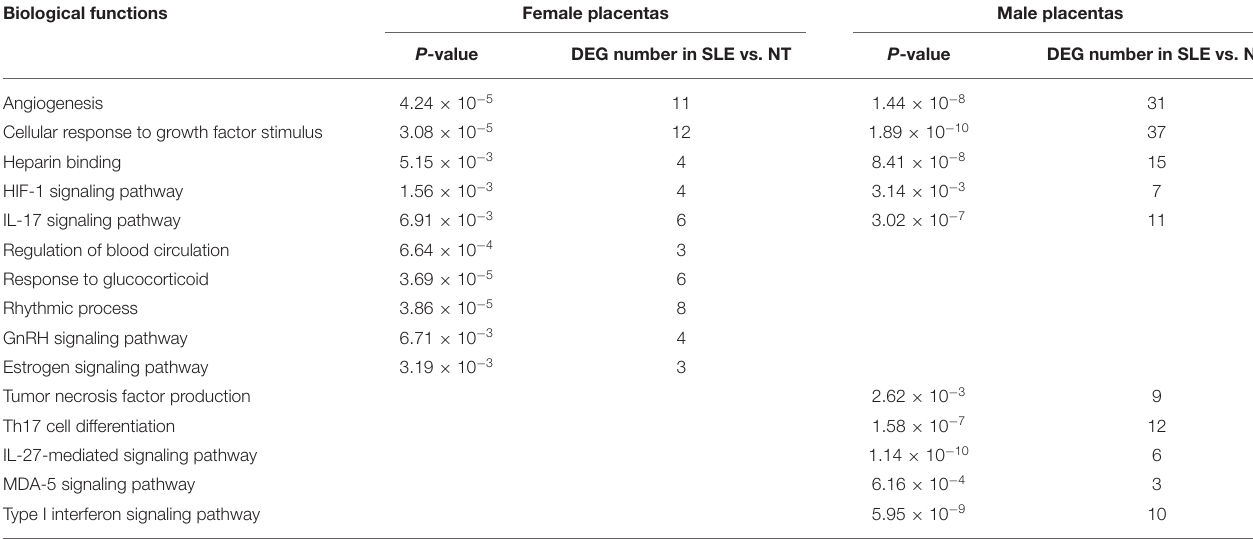
TABLE 2 | SLE dysregulated biological functions in female and male placentas. Biological functions Female placentas Male placentas P -value DEG number in SLE vs. NT P -value DEG number in SLE vs.